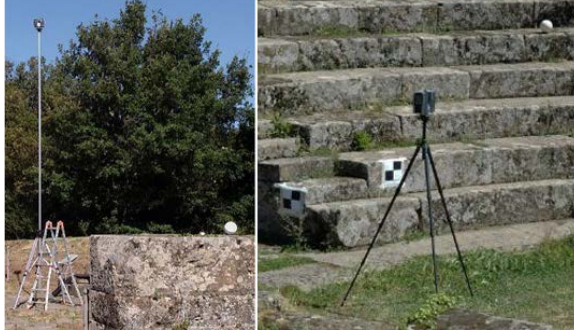
Figure 5. Some laser scanning stations with the use of spherical and chessboard targets